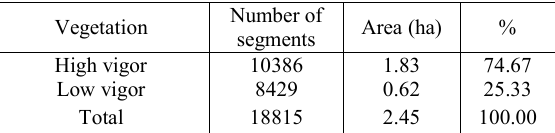
Table 1. Vegetation distribution by class.